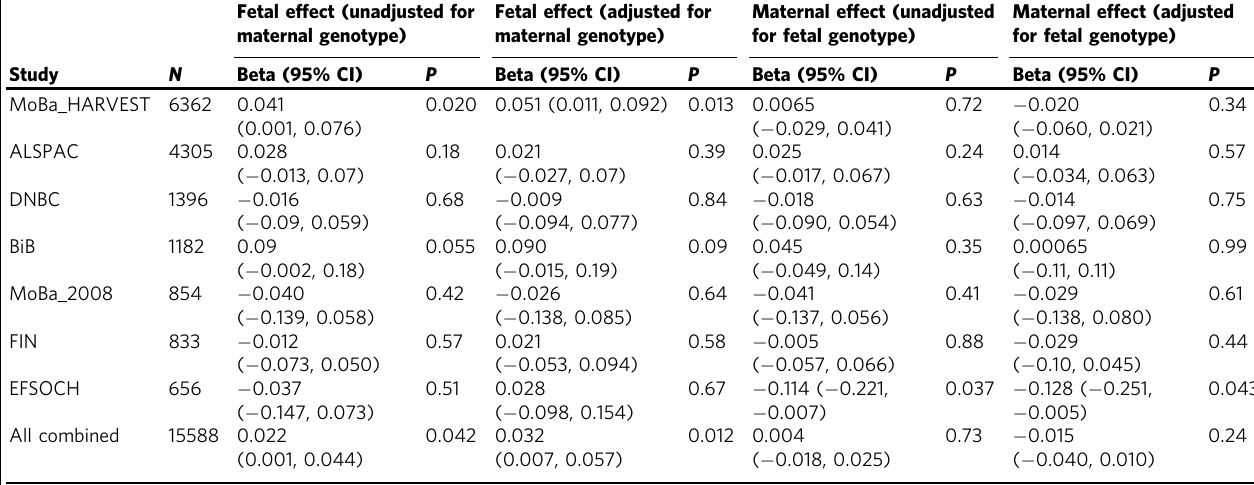
Table 2 Associations in 15,588 mother – child pairs between rs7594852 genotype and gestational duration Fetal effect (unadjusted for Fetal effect (adjusted for Maternal effect (unadjusted Maternal effect (adjusted maternal genotype) maternal genotype) for fetal genotype) for fetal